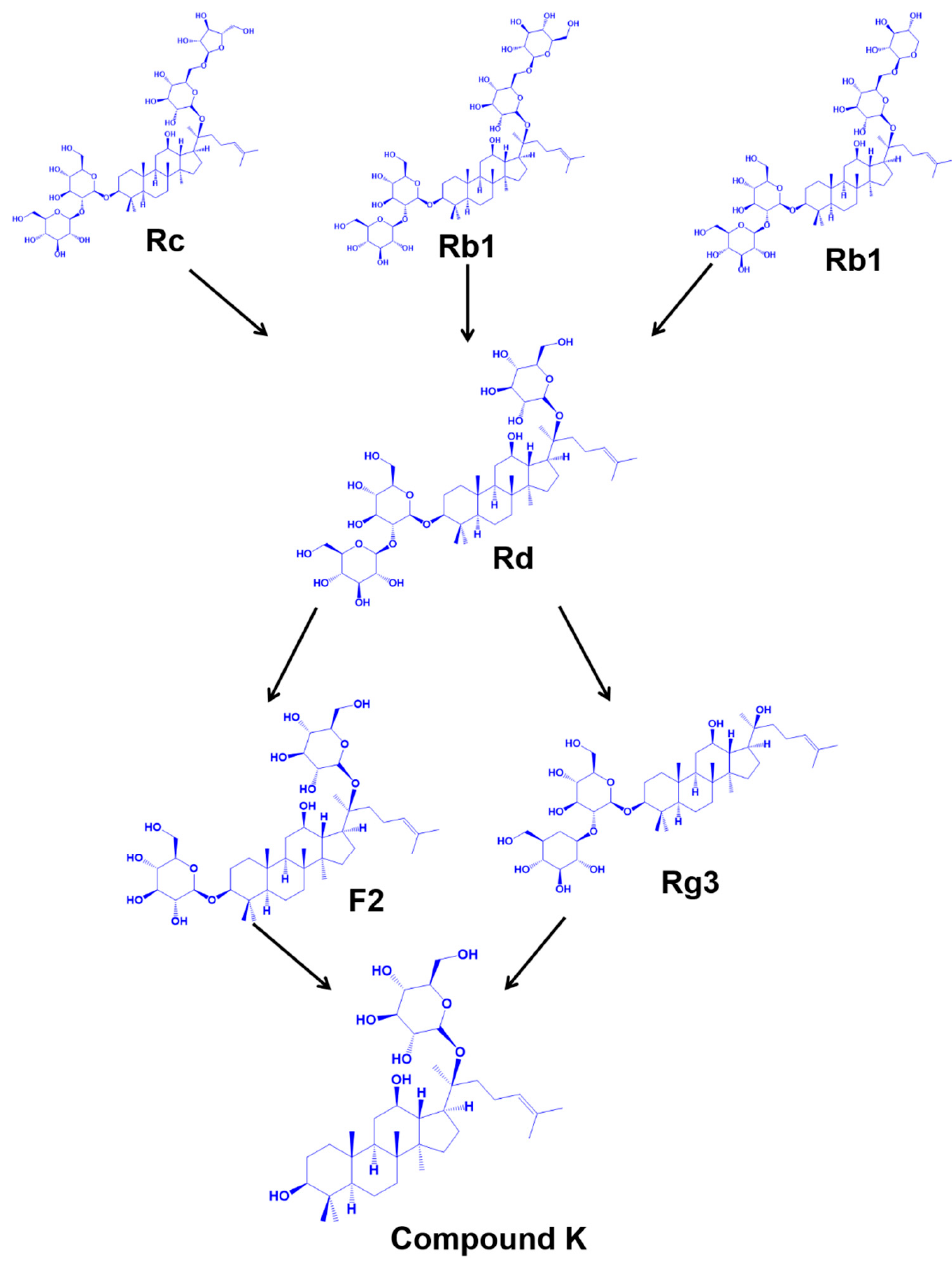
Figure 4. Biotransformation of major ginsenosides into more active CK.